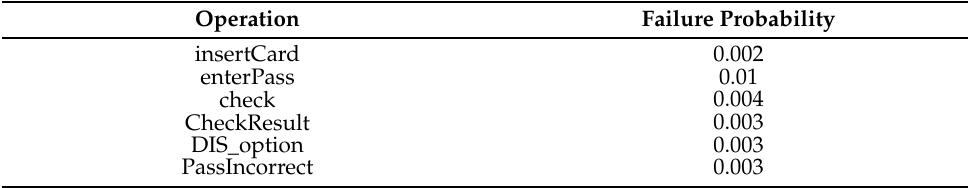
Table 2. Operations’ failure information for the password verification